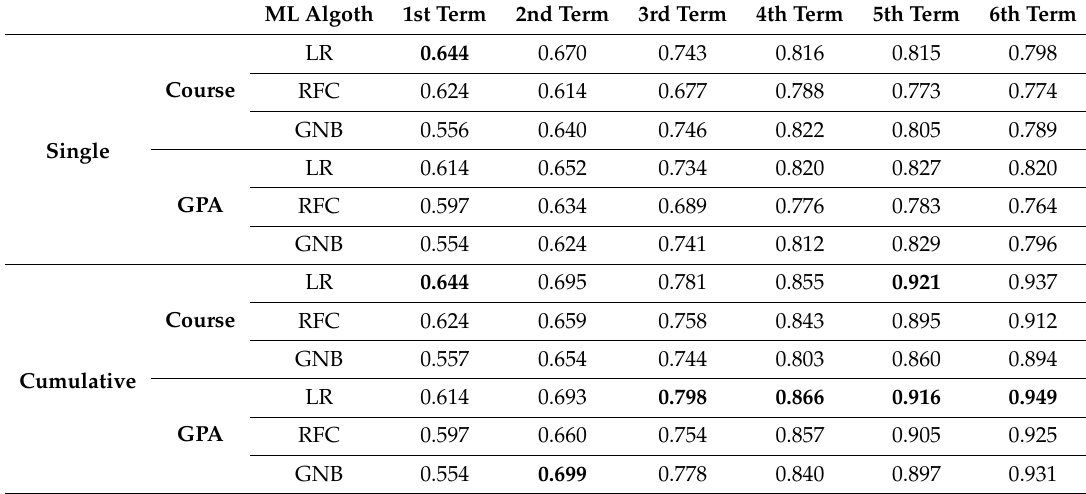
Table 7. Accuracy results of the ML Models with the academic and demographic features. ML Algoth 1st Term 2nd